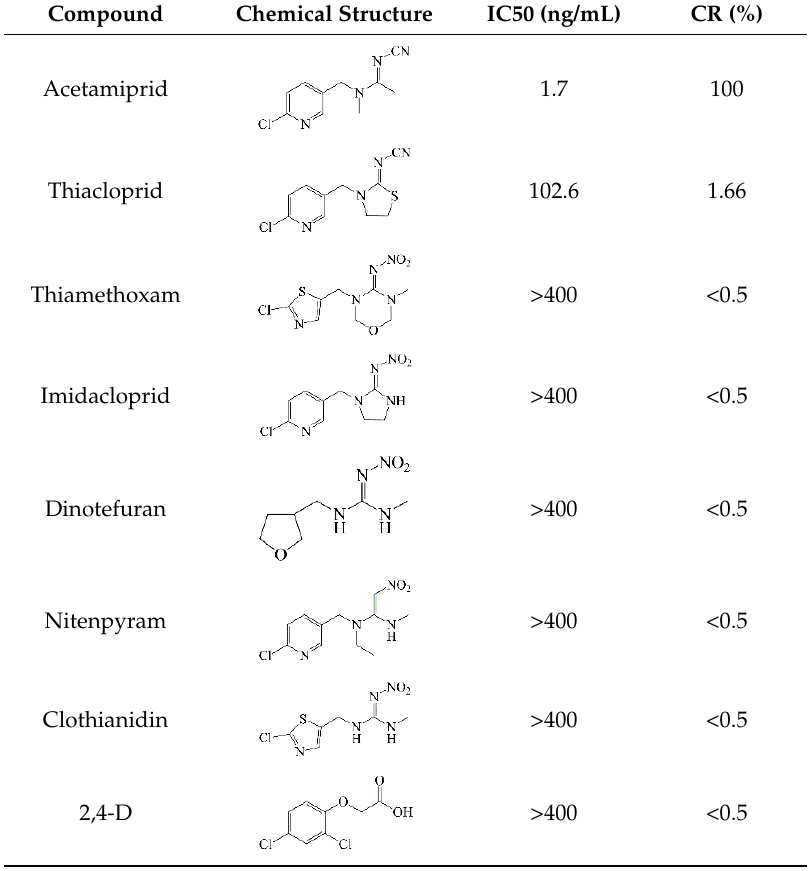
Table 1. The cross-reactivity (CR) of acetamiprid toward other analogues.